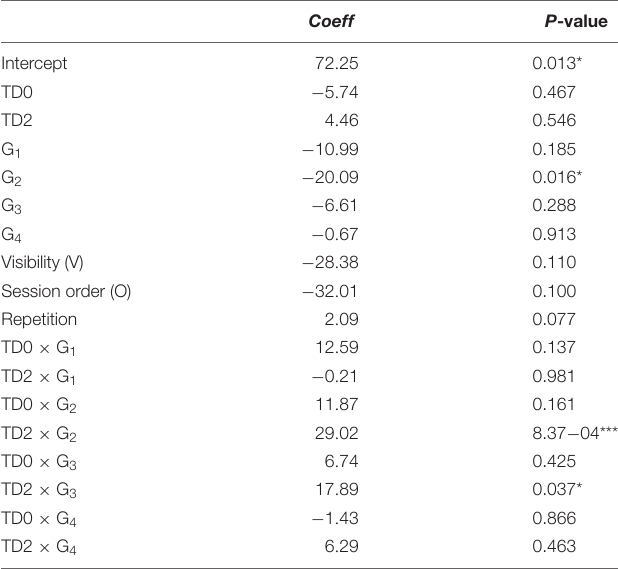
TABLE 11 | Interval between the instant in which hitter arrived at instantaneous minimum distance from the ball surface considering ball gravitational free-fall (GIP), and the maximum speed